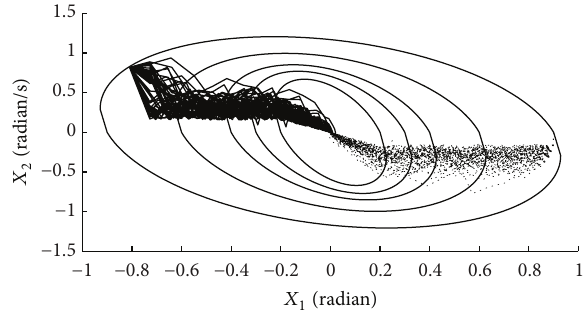
Figure 4: The state trajectories of the closed-loop system in Example 2.